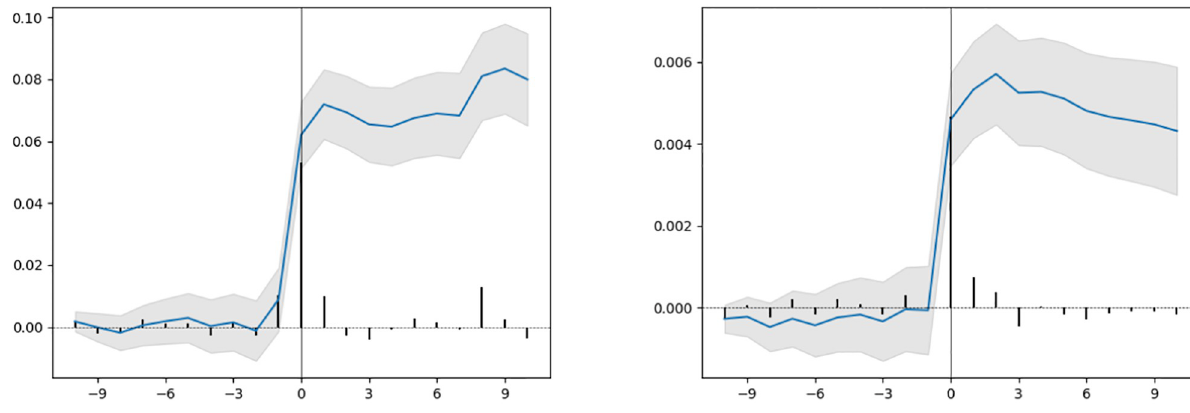
Fig 4. Left: Early positive outcome, Right: Primary endpoints met.